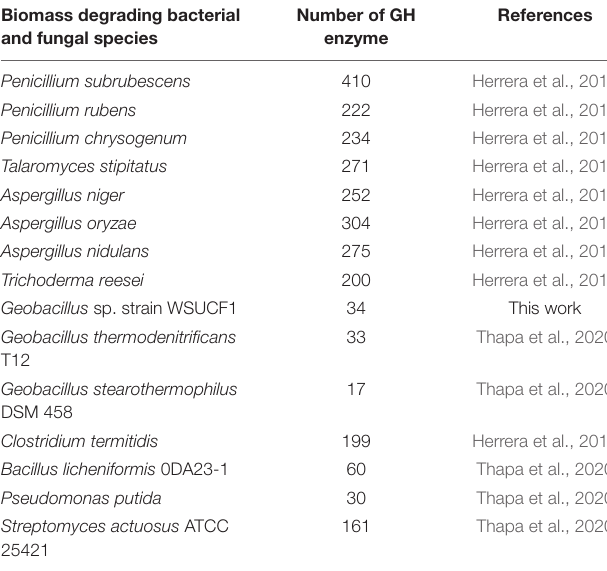
TABLE 1 | Count comparisons of GH enzymes in Geobacillus sp. strain WSUCF1 to other organisms. Biomass degrading bacterial and fungal